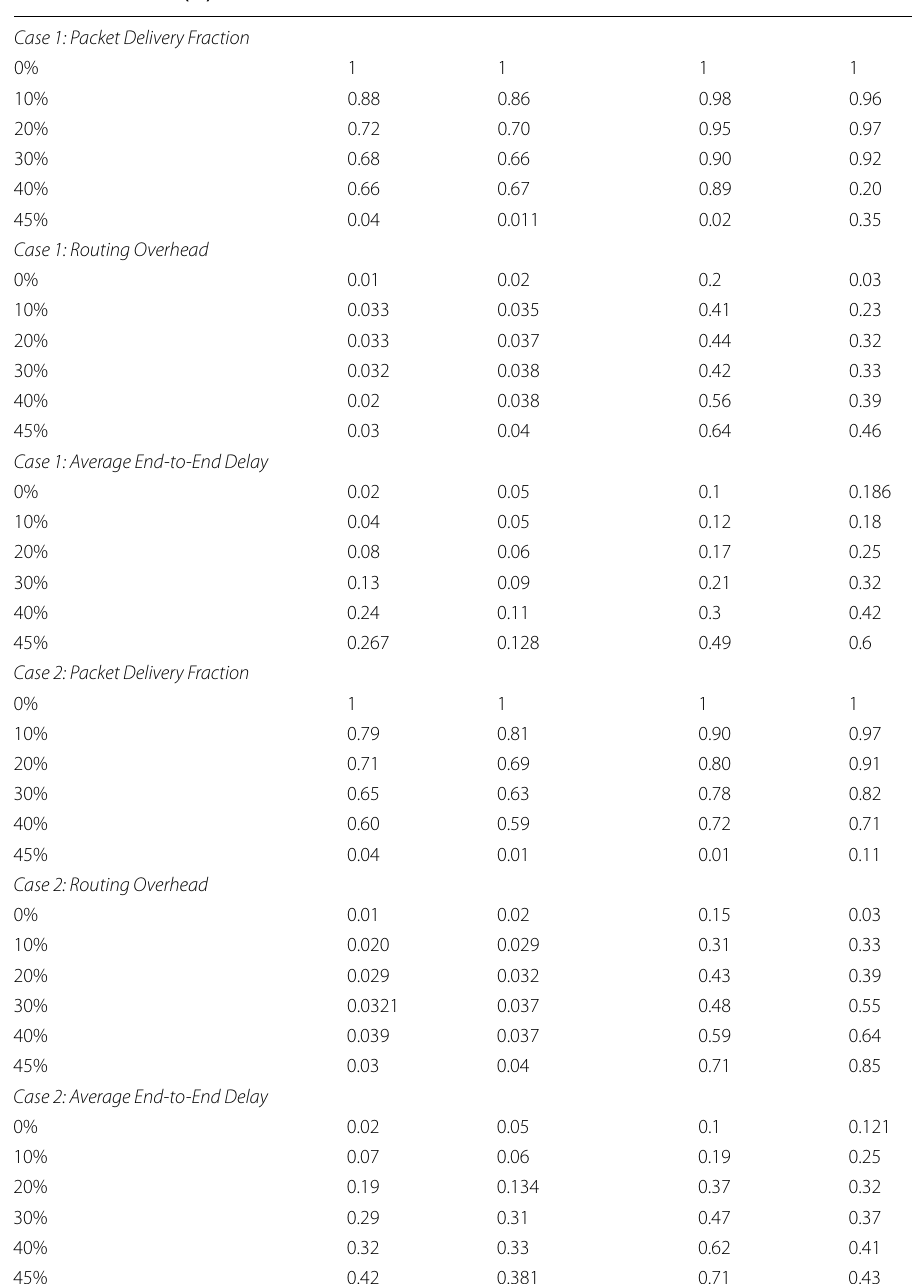
Table 6 Average results